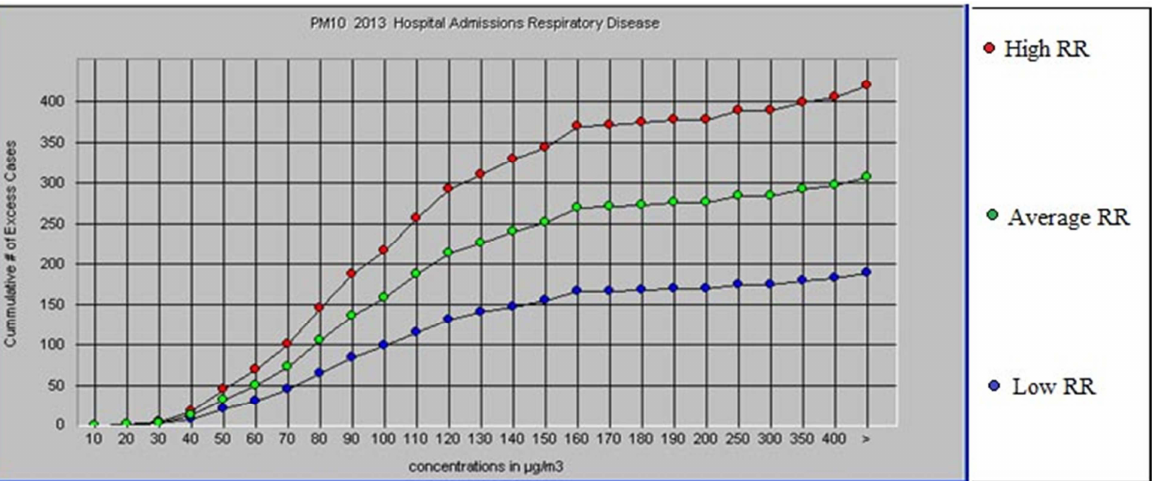
Figure 9. Estimated cumulative number of hospital admission respiratory diseases cases attributable to particulate matter with aerodynamic diameters <10 µm comparing concentration intervals (Sanandaj, Iran, 2013) RR: Relative